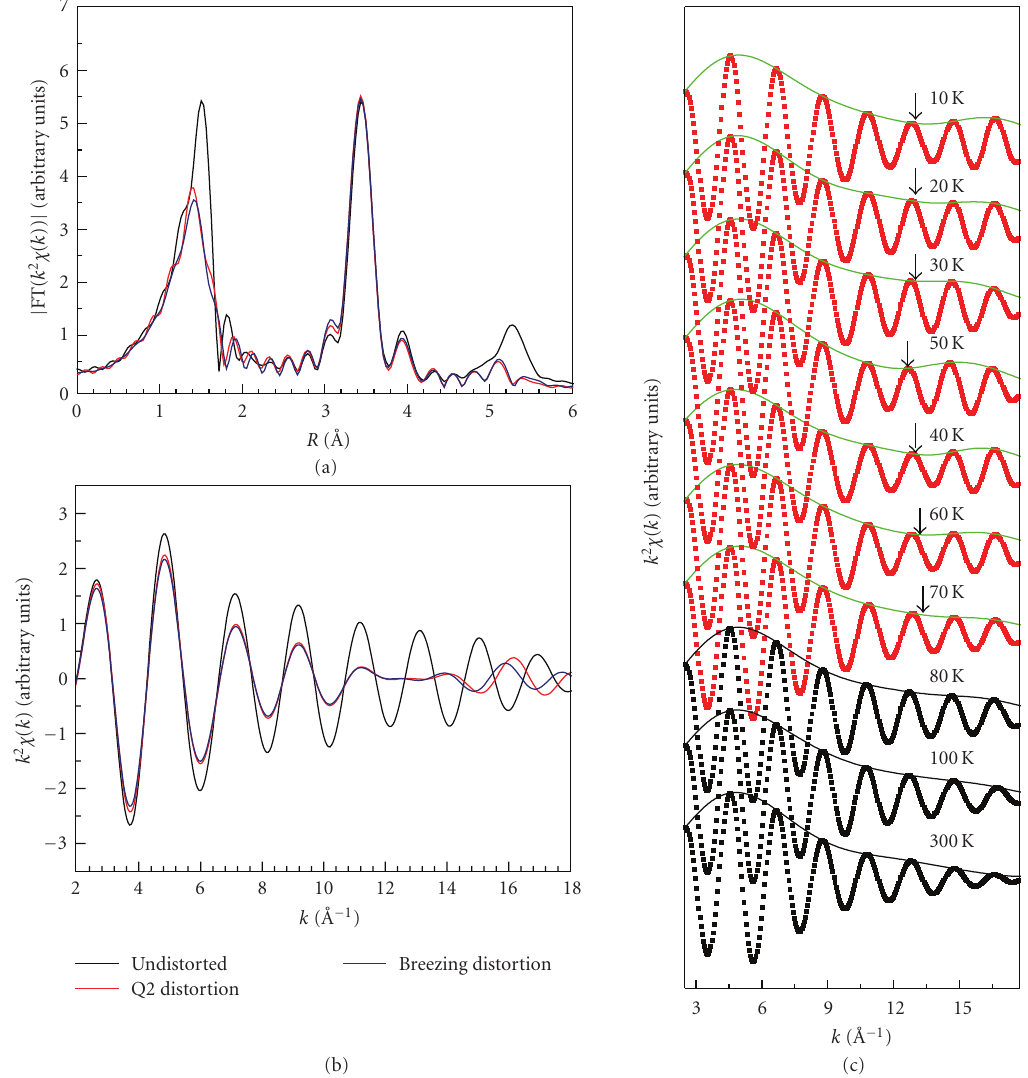
Figure 5: (a) Fourier transform magnitude curves of simulated E//ab EXAFS oscillations for undistorted (solid line) and distorted CuO 4 - CuO 4 units (red curve: JT Q 2 mode, purple curve: pseudo-JT (breezing) mode distortions). (b) Nearest neighbour contribution of simulated EXAFS oscillations for undistorted and distorted models. Interference of long and short Cu–O bonds give rise to beat features at k ∼ 12 ˚ A − 1 . (c) Experimental nearest neighbor Cu-O EXFS curves measured at various temperatures. Beat feature similar to (b) is observed at k = 14 ˚ A − 1 near T c (40